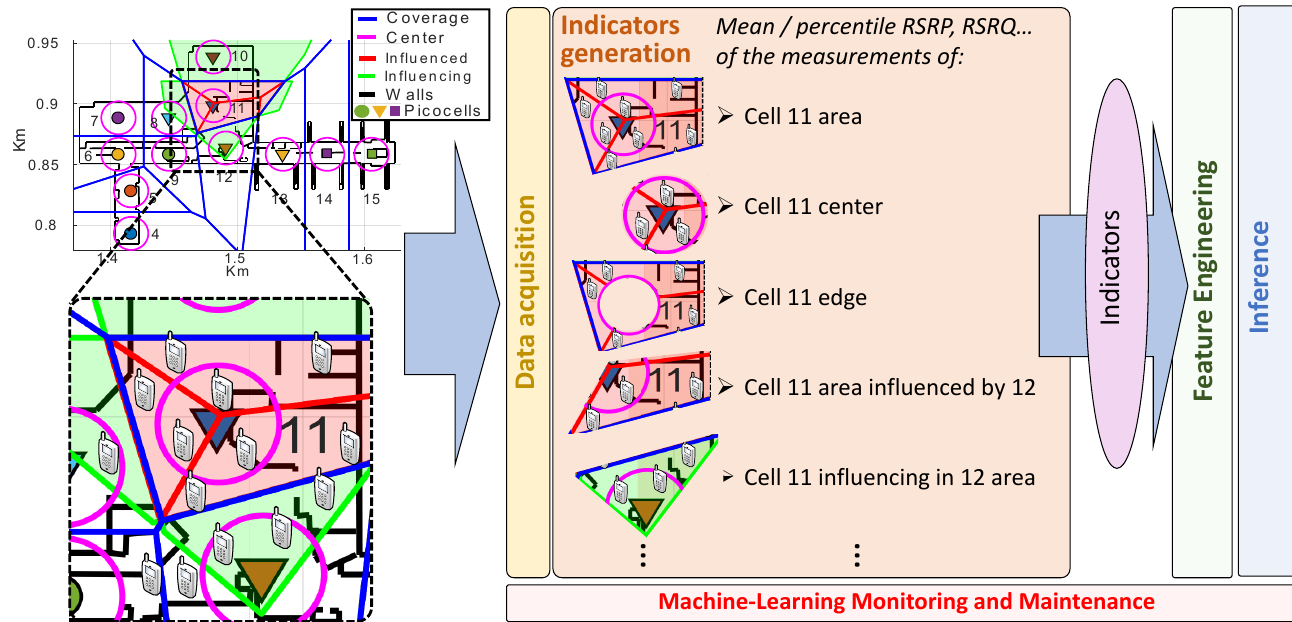
Figure 3. Area-based automatic indicators generation in CAFAIM, showing cell 11 proper, influenced, and influencing areas for an airport